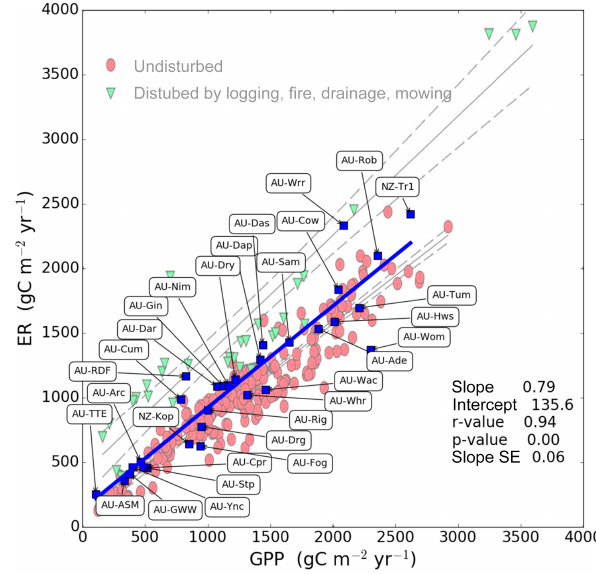
Figure 4. Relationship between site-averaged ecosystem respiration (ER) and gross primary production (GPP) for all OzFlux tower sites (blue squares) showing they are well correlated ( r 2 = 0.93) with a slope of 0.79. This compares with slope of 0.77 in an international synthesis by Baldocchi (2008). The results from the international study (red and green symbols) are shown in the background and show a secondary line where disturbed sites (green triangles) had Figure 3. Weekly ensemble from the Australian OzFlux sites of large positive values of net ecosystem productivity (NEP) (carbon the measured net ecosystem productivity (NEP) (a) and compo- source). Few Australian sites reach that level of disturbance. Solid nent gross primary production (GPP) (b) and ecosystem respiration Figure 3: Weekly ensemble from the Australian OzFlux sites of the measured Net Ecosystem Productivity (NEP) (a) 1060 lines are regressions; dashed lines are 95% confidence intervals. and component Gross Primary Production (GPP) (b) and Ecosystem Respiration (ER) (b) for all OzFlux tower sites in (ER) (c) for all OzFlux tower sites in each biome as follows: Figure 3: Weekly ensemble from the Australian OzFlux sites of the measured Net Ecosystem Productivity (NEP) (a) 1060 Figure 3: Weekly ensemble from the Australian OzFlux sites of the measured Net Ecosystem Productivity (NEP) (a) 1060 each biome as follows temperate woodlands, tropical savannas, desert shrublands, Figure 3: Weekly ensemble from the Australian OzFlux sites of the measured Net Ecosystem Productivity (NEP) (a) 1060 Figure 3: Weekly ensemble from the Australian OzFlux sites of the measured Net Ecosystem Productivity (NEP) (a) 1060 and component Gross Primary Production (GPP) (b) and Ecosystem Respiration (ER) (b) for all OzFlux tower sites in and component Gross Primary Production (GPP) (b) and Ecosystem Respiration (ER) (b) for all OzFlux tower sites in tropical grasslands, mediterranean woodands, temperate broadleaf forests, pasture, temperate woodlands, tropical savannas, desert shrublands, Figure 3: Weekly ensemble from the Australian OzFlux sites of the measured Net Ecosystem Productivity (NEP) (a) 1060 and component Gross Primary Production (GPP) (b) and Ecosystem Respiration (ER) (b) for all OzFlux tower sites in and component Gross Primary Production (GPP) (b) and Ecosystem Respiration (ER) (b) for all OzFlux tower sites in each biome as follows temperate woodlands, tropical savannas, desert shrublands, each biome as follows temperate woodlands, tropical savannas, desert shrublands, tropical moist broadleaf forests and montane grasslands. The sites used in each biome are shown in Table 1. Figure 3: Weekly ensemble from the Australian OzFlux sites of the measured Net Ecosystem Productivity (NEP) (a) 1060 Figure 3: Weekly ensemble from the Australian OzFlux sites of the measured Net Ecosystem Productivity (NEP) (a) 1060 each biome as follows temperate woodlands, tropical savannas, desert shrublands, each biome as follows temperate woodlands, tropical savannas, desert shrublands, and component Gross Primary Production (GPP) (b) and Ecosystem Respiration (ER) (b) for all OzFlux tower sites in Figure 3: Weekly ensemble from the Australian OzFlux sites of the measured Net Ecosystem Productivity (NEP) (a) 1060 tropical grasslands, mediterranean woodands, temperate broadleaf forests, pasture, tropical grasslands, mediterranean woodands, temperate broadleaf forests, pasture, tropical grasslands, mediterranean woodlands, tem- and component Gross Primary Production (GPP) (b) and Ecosystem Respiration (ER) (b) for all OzFlux tower sites in GPP generally scales with Leaf Area Index (LAI) and water availability. Most of the variability follows the respective 1065 and component Gross Primary Production (GPP) (b) and Ecosystem Respiration (ER) (b) for all OzFlux tower sites in each biome as follows temperate woodlands, tropical savannas, desert shrublands, tropical grasslands, mediterranean woodands, temperate broadleaf forests, pasture, tropical grasslands, mediterranean woodands, temperate broadleaf forests, pasture, and component Gross Primary Production (GPP) (b) and Ecosystem Respiration (ER) (b) for all OzFlux tower sites in tropical moist broadleaf forests and montane grasslands. The sites used in each biome are shown in Table 1. tropical moist broadleaf forests and montane grasslands. The sites used in each biome are shown in Table 1. rainfall patterns associated with the tropical, mediterranean, and temperate climates. each biome as follows temperate woodlands, tropical savannas, desert shrublands, each biome as follows temperate woodlands, tropical savannas, desert shrublands, tropical grasslands, mediterranean woodands, temperate broadleaf forests, pasture, tropical moist broadleaf forests and montane grasslands. The sites used in each biome are shown in Table 1. perate broadleaf forests, pasture, tropical moist broadleaf tropical moist broadleaf forests and montane grasslands. The sites used in each biome are shown in Table 1. each biome as follows temperate woodlands, tropical savannas, desert shrublands, GPP generally scales with Leaf Area Index (LAI) and water availability. Most of the variability follows the respective 1065 GPP generally scales with Leaf Area Index (LAI) and water availability. Most of the variability follows the respective 1065 tropical grasslands, mediterranean woodands, temperate broadleaf forests, pasture, tropical grasslands, mediterranean woodands, temperate broadleaf forests, pasture, tropical moist broadleaf forests and montane grasslands. The sites used in each biome are shown in Table 1. GPP generally scales with Leaf Area Index (LAI) and water availability. Most of the variability follows the respective 1065 warmer and drier than average conditions, whilst cooler and GPP generally scales with Leaf Area Index (LAI) and water availability. Most of the variability follows the respective 1065 rainfall patterns associated with the tropical, mediterranean, and temperate climates. rainfall patterns associated with the tropical, mediterranean, and temperate climates. tropical grasslands, mediterranean woodands, temperate broadleaf forests, pasture, tropical moist broadleaf forests and montane grasslands. The sites used in each biome are shown in Table 1. tropical moist broadleaf forests and montane grasslands. The sites used in each biome are shown in Table 1. GPP generally scales with Leaf Area Index (LAI) and water availability. Most of the variability follows the respective 1065 forests, and montane grasslands. The sites used in each biome 40 rainfall patterns associated with the tropical, mediterranean, and temperate climates. rainfall patterns associated with the tropical, mediterranean, and temperate climates. tropical moist broadleaf forests and montane grasslands. The sites used in each biome are shown in Table 1. GPP generally scales with Leaf Area Index (LAI) and water availability. Most of the variability follows the respective 1065 GPP generally scales with Leaf Area Index (LAI) and water availability. Most of the variability follows the respective 1065 rainfall patterns associated with the tropical, mediterranean, and temperate climates. wetter conditions are characteristic of the La Niña phase GPP generally scales with Leaf Area Index (LAI) and water availability. Most of the variability follows the respective 1065 are shown in Table 1. GPP generally scales with leaf area index rainfall patterns associated with the tropical, mediterranean, and temperate climates. 40 rainfall patterns associated with the tropical, mediterranean, and temperate climates. 40 40 rainfall patterns associated with the tropical, mediterranean, and temperate climates. 40 (Nicholls et al., 1991; Power et al., 1999), and together 40 (LAI) and water availability. Most of the variability follows the 40 40 40 respective rainfall patterns associated with the tropical, mediter- ranean, and temperate climates.